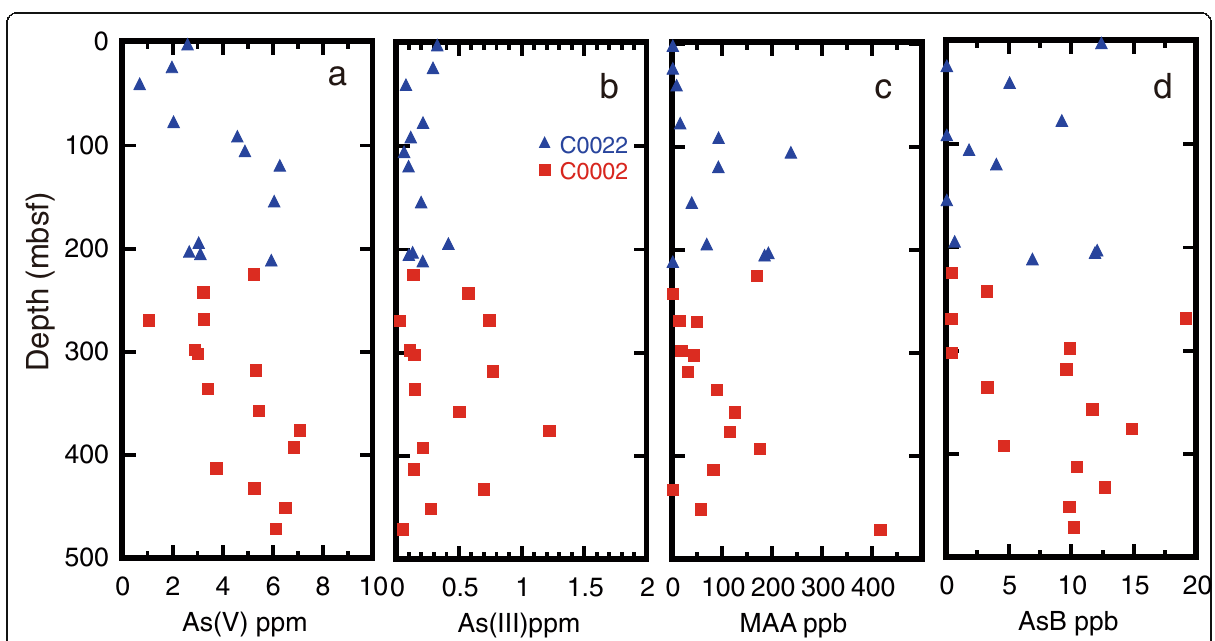
Fig. 5 Arsenic speciation of sediments separated by HPLC-ICP-MS after extraction by mixing solution of hydroxylammonium chloride and phosphoric acid in relation to the depth a Arsenate. b arsenite. c methylarsonic acid. d arsenobetaine